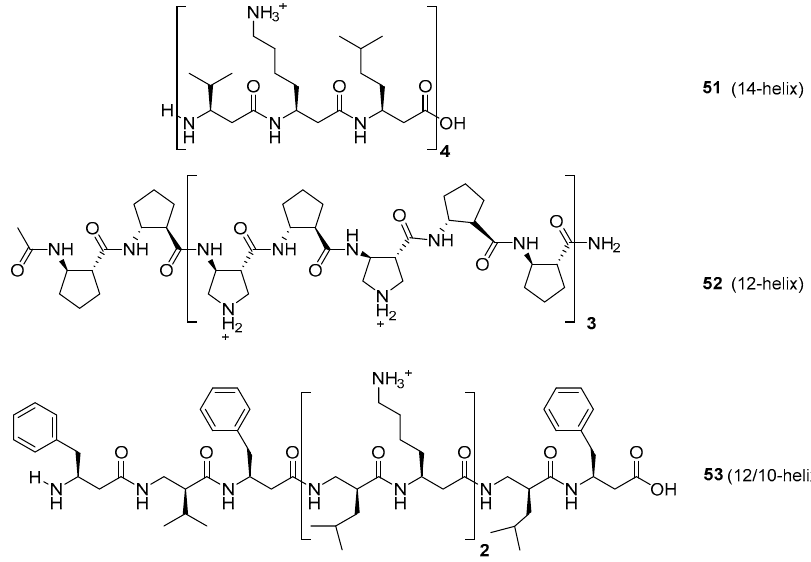
Figure 8. β -peptides with alternating hydrophobic and cationic units and different folding patterns.